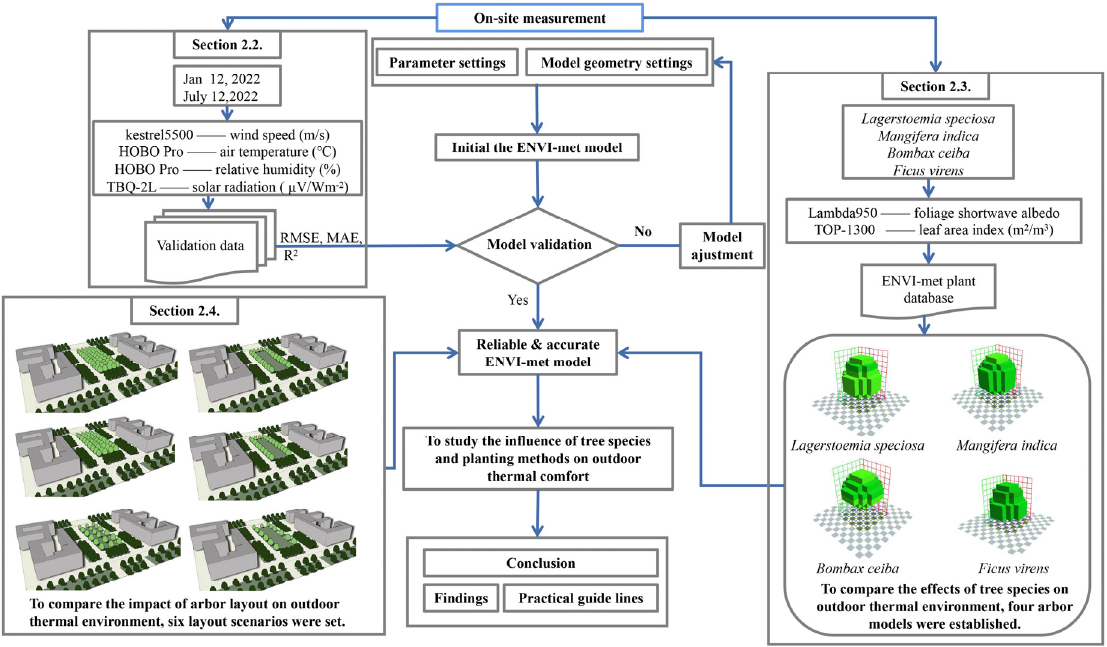
Figure 1. Research framework (The content details of key Sections 2.2–2.4).